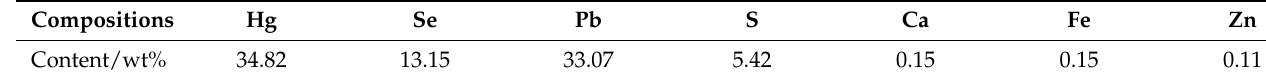
Table 1. Chemical compositions of MAM.